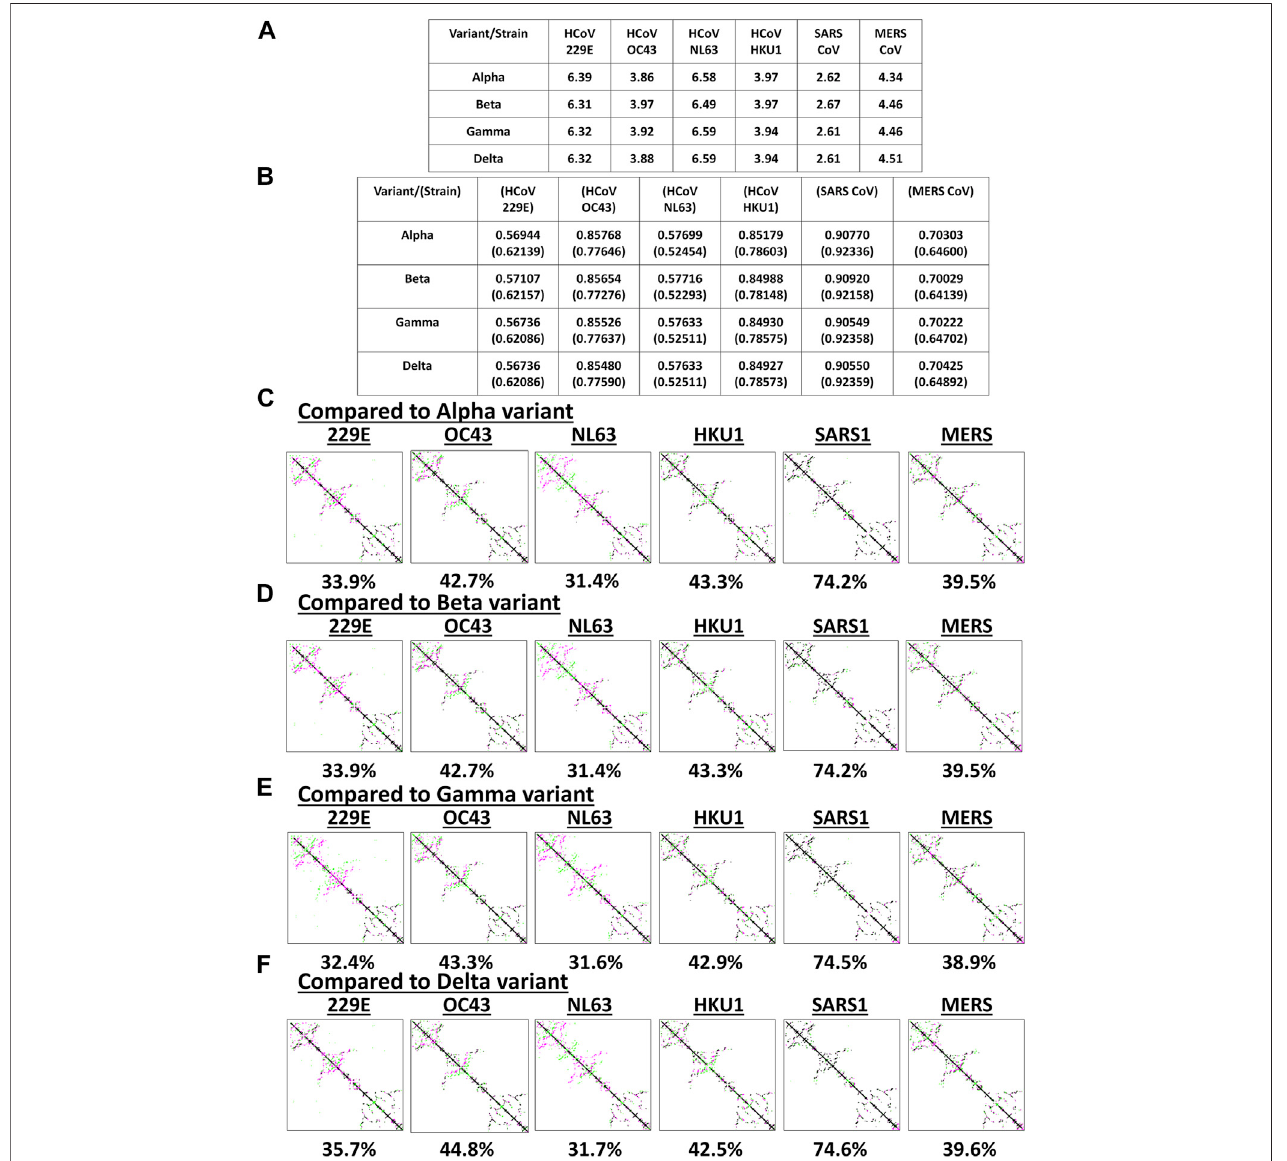
FIGURE 3 | Structural comparison of the original SARS2 and endemic HCoV spike models based on the whole protein. (A) RMSD values and (B) TM scores of superimposedspikemodelsaretabulated.TMscoresnormalizedtoaspikemodelisdistinguishedbythepresenceorabsenceofaparenthesis.Contactmapsofthe (C) alpha variant relative to other endemic HCoV (D) beta variant relative to other endemic HCoV (E) gamma variant relative to other endemic HCoV, and (F) delta variant relative to other endemic HCoV are shown. Common contact of the protein structures being compared are labeled below. Endemic HCoVs [HCoV 229E (229E), HCoV OC43 (OC43), HCoV NL63 (NL63), HCoV HKU1 (HKU1), SARS-CoV-1 (SARS1), and MERS CoV (MERS)] are indicated. Contacts present in both protein structures (black) and present in one of the protein structures [either pink ( fi rst protein structure uploaded: VOC) or green (second protein structure uploaded: endemic HCoV)] are